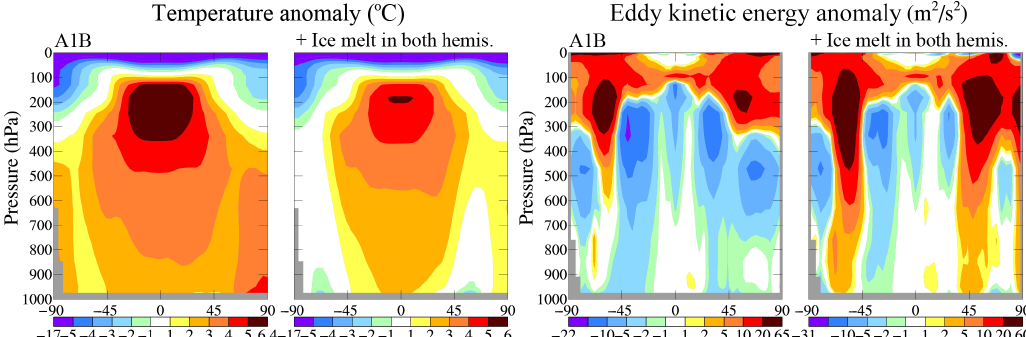
Figure 21. Simulated zonal-mean atmospheric temperature ( ◦ C) and eddy kinetic energy (m 2 s − 2 ) in 2078–2082 relative to 1880–1920 for A1B scenario and A1B plus 2.5m ice melt in each